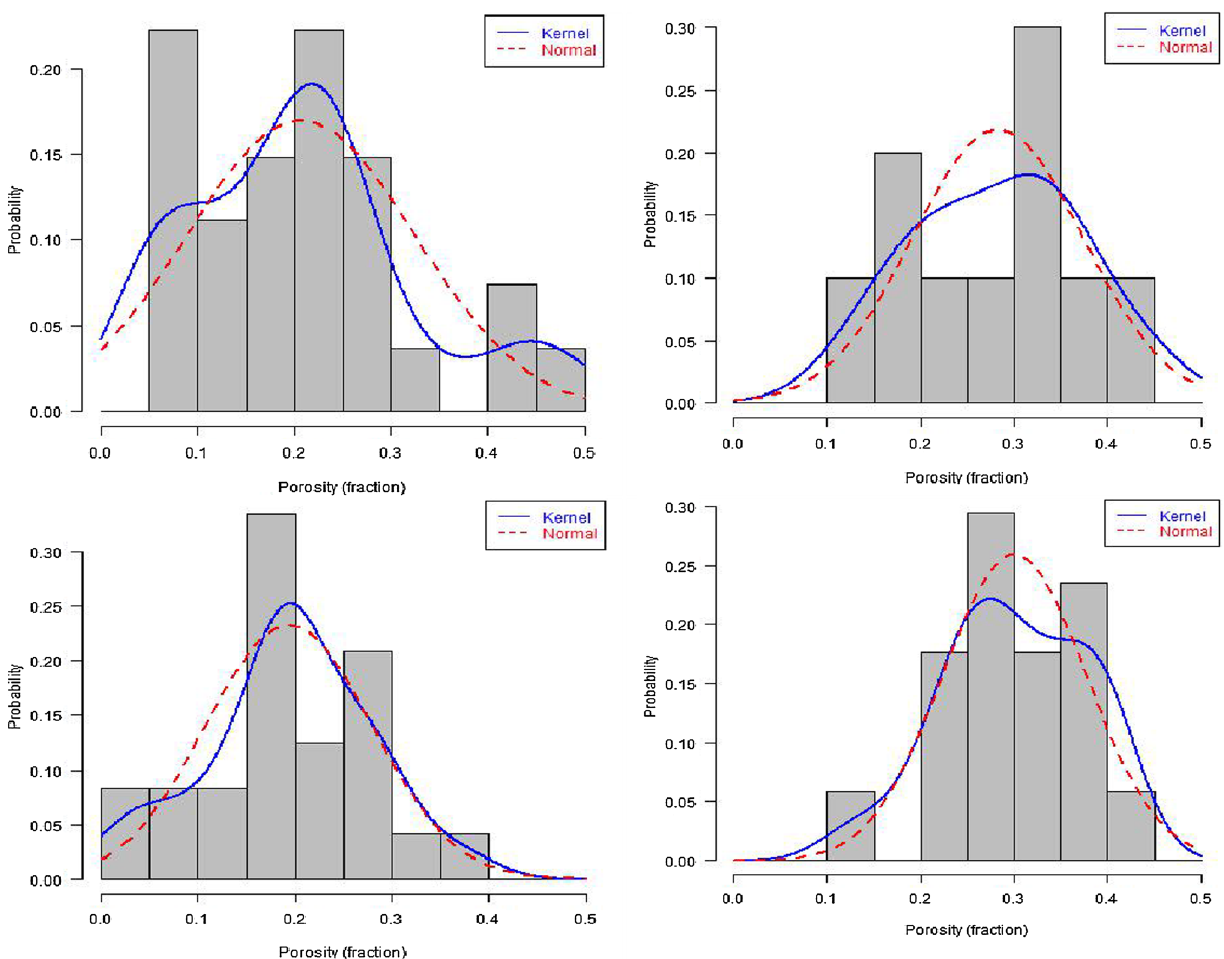
Fig. 19 Porosity values distributions for Well BH 10 (top left), Well BH 17 (top right), Well BH 23 (bottom left), and Well BH 50 (bottom right) Table 1 Outputs of well-level two-sided two-sample t